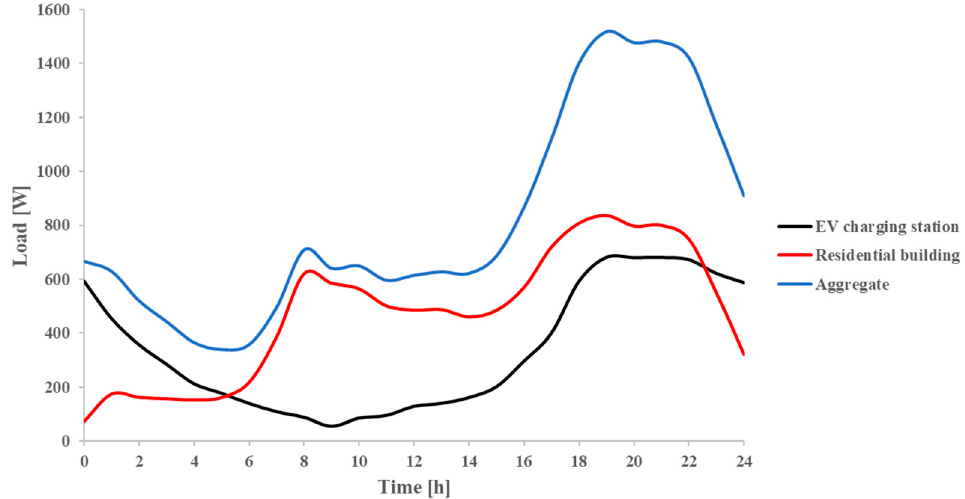
Figure 2. Different load demands applied to system [20,21].